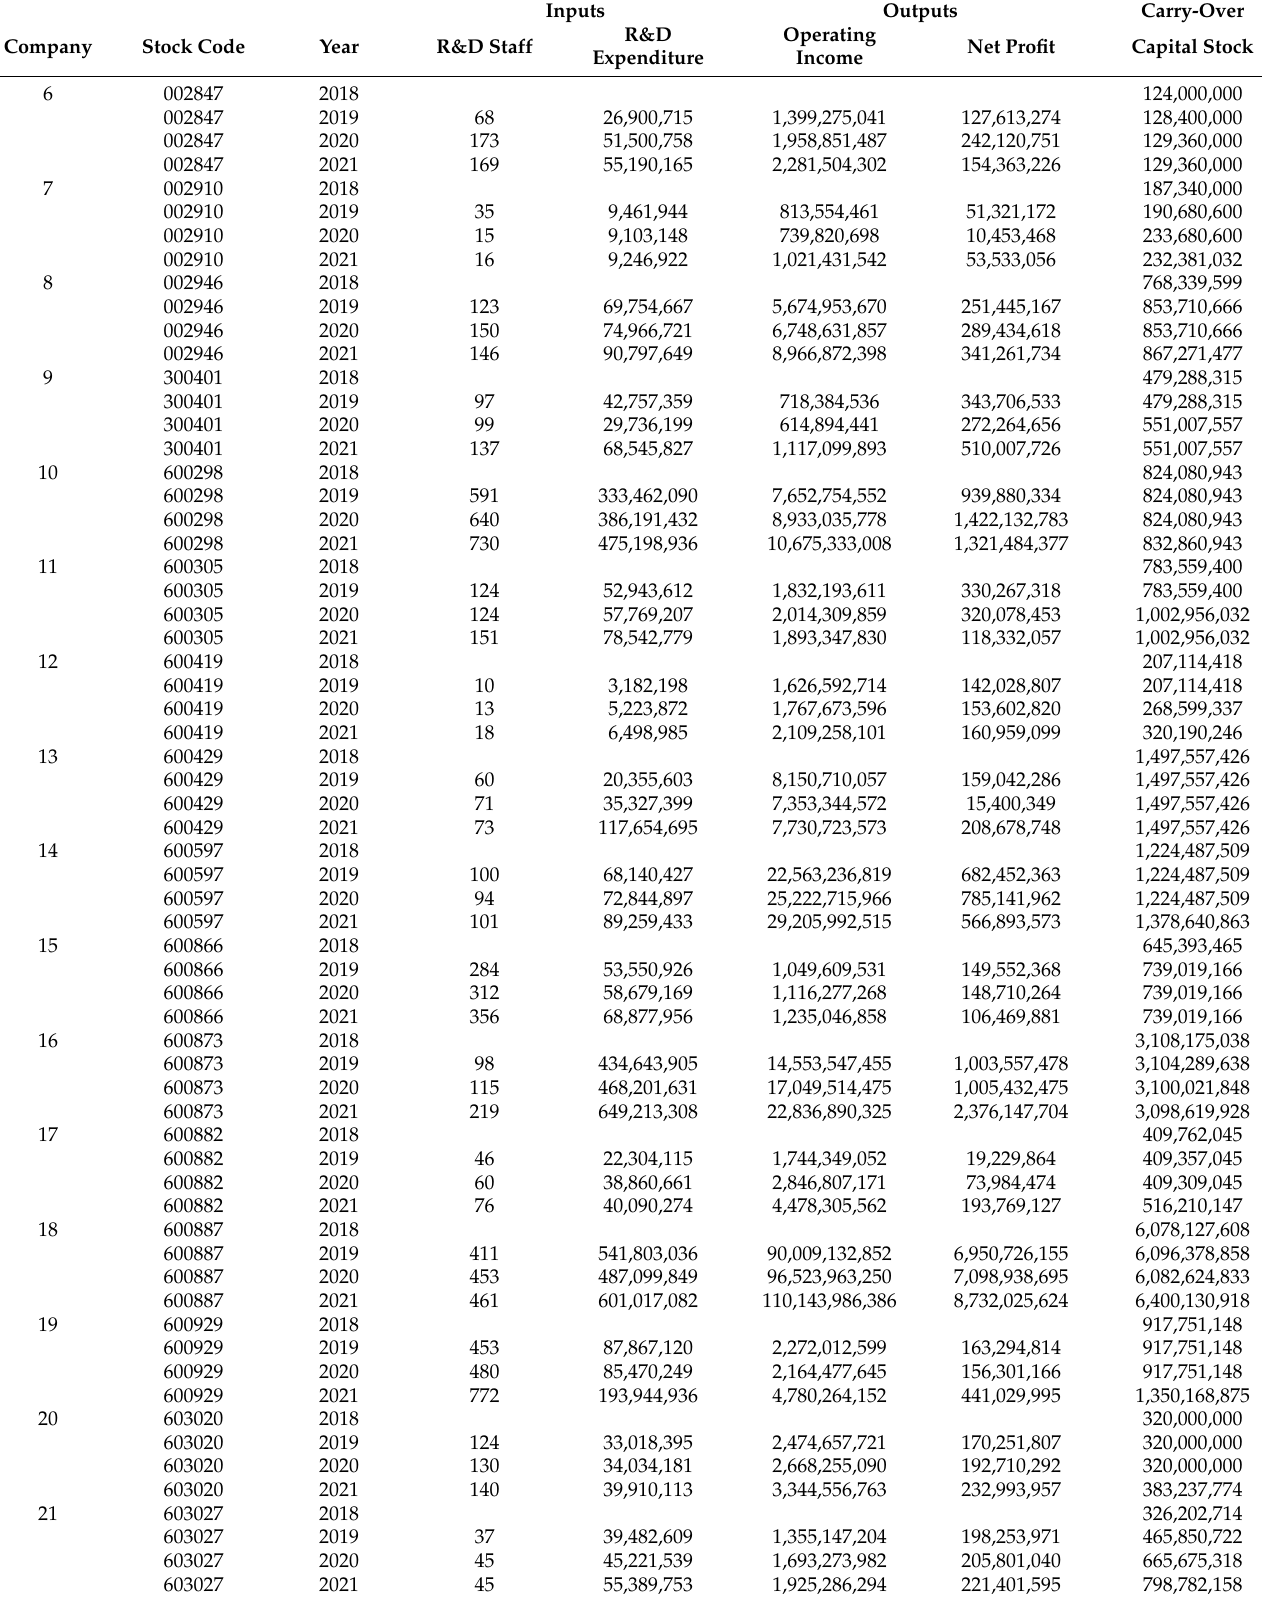
Table A1. Cont. Inputs Outputs